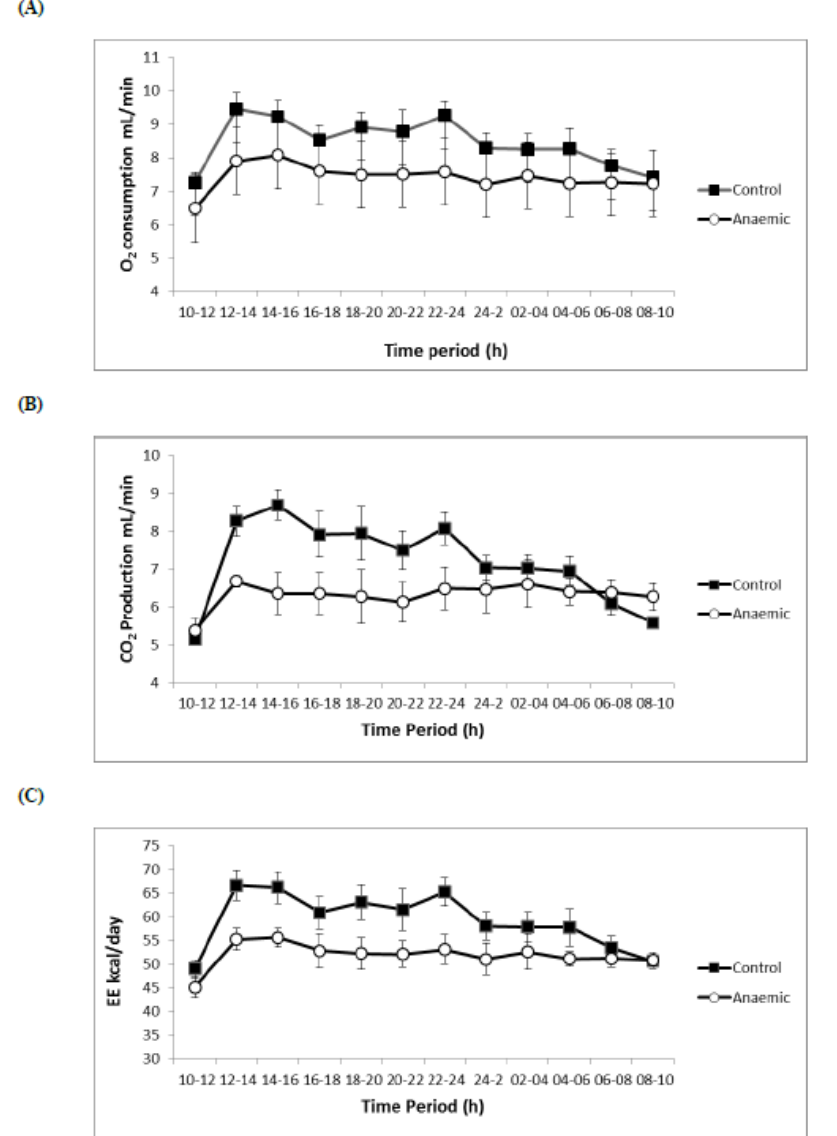
Figure 1. Effect of time of day and anaemia on metabolic parameters. Rats were surveyed every 10 minutes at an ambient temperature of 22 ± 2 °C. All data are expressed as means ± SEM. ( A ) oxygen consumption (VO 2 ), ( B ) carbon dioxide production (VCO 2 ), ( C ) Energy expenditure (EE). Table 5. O 2 consumption, CO 2 production, energy expenditure and respiratory quotient in control and anaemic rats.